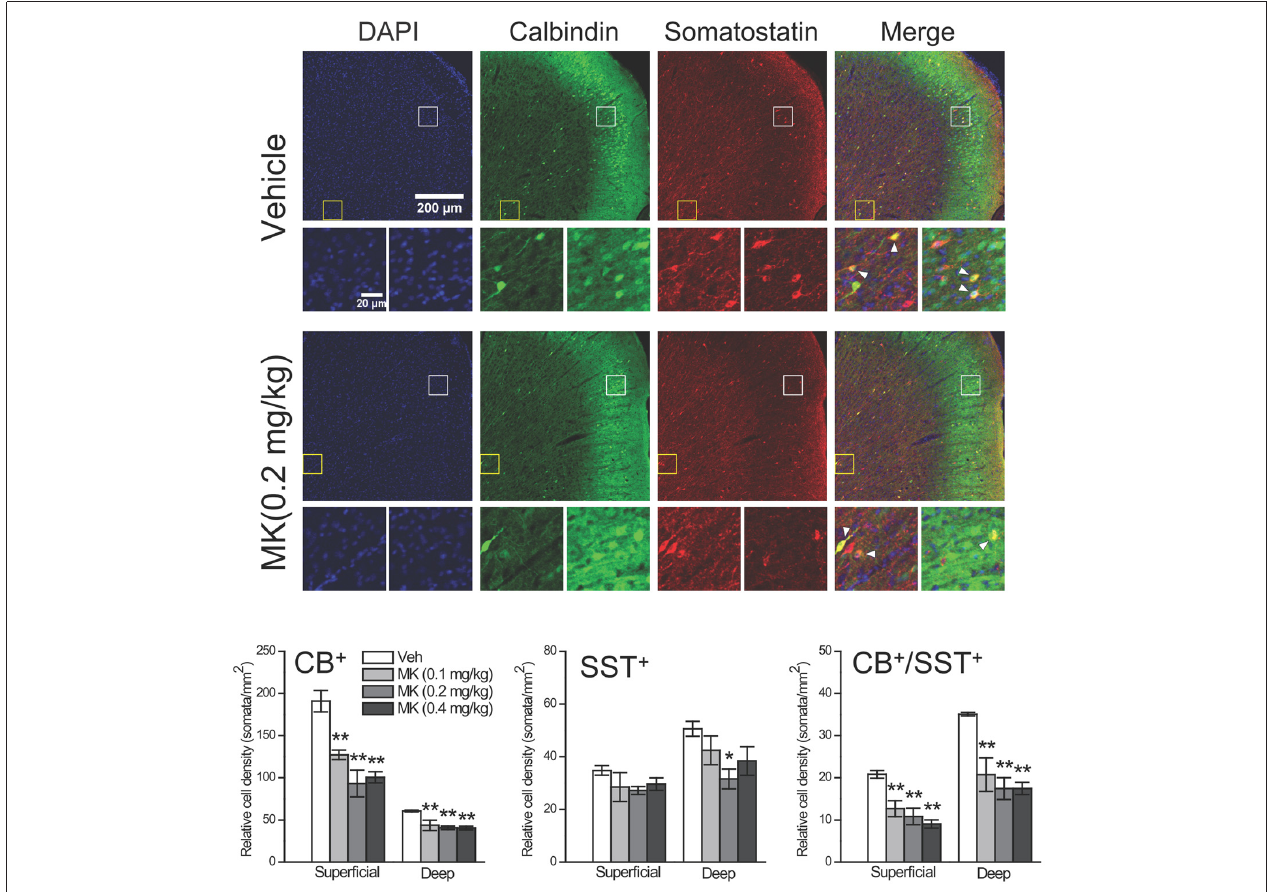
FIGURE 5 | Effects of subchronic treatment of MK-801 (0.1, 0.2, 0.4 mg/kg, once daily) during adolescence (PND 29–42) on relative density of CB + interneurons that co-express somatostatin (SST) in the superficial and deep layers of the cingulate subregion 24 h after drug cessation. Representative confocal images show both superficial and deep layers of the cingulate subregion immunostained for DAPI, CB and SST in animals receiving either vehicle or MK-801 (0.2 mg/kg) treatment. Interneurons in superficial (white box) and deep (yellow box) layers are shown in the bottom row. CB + /SST + interneurons are labeled with arrowhead. n = 4 per group. ∗ p < 0.05, ∗∗ p < 0.01 compared with the vehicle